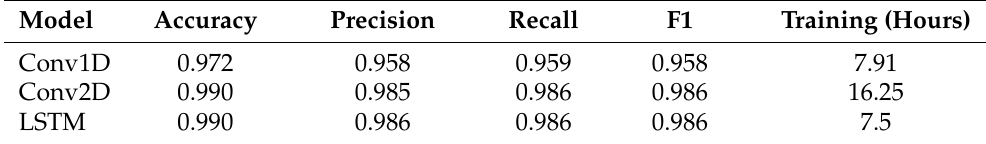
Table 5. Performance evaluation and training time required by all three models with 8.5 s split